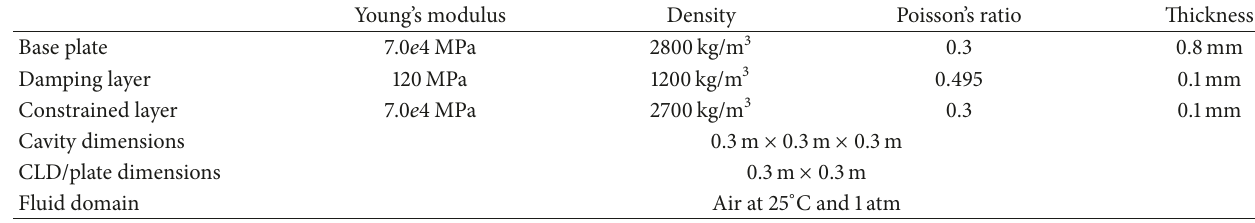
Table 1: Geometrical and physical parameters for closed acoustic cavity.